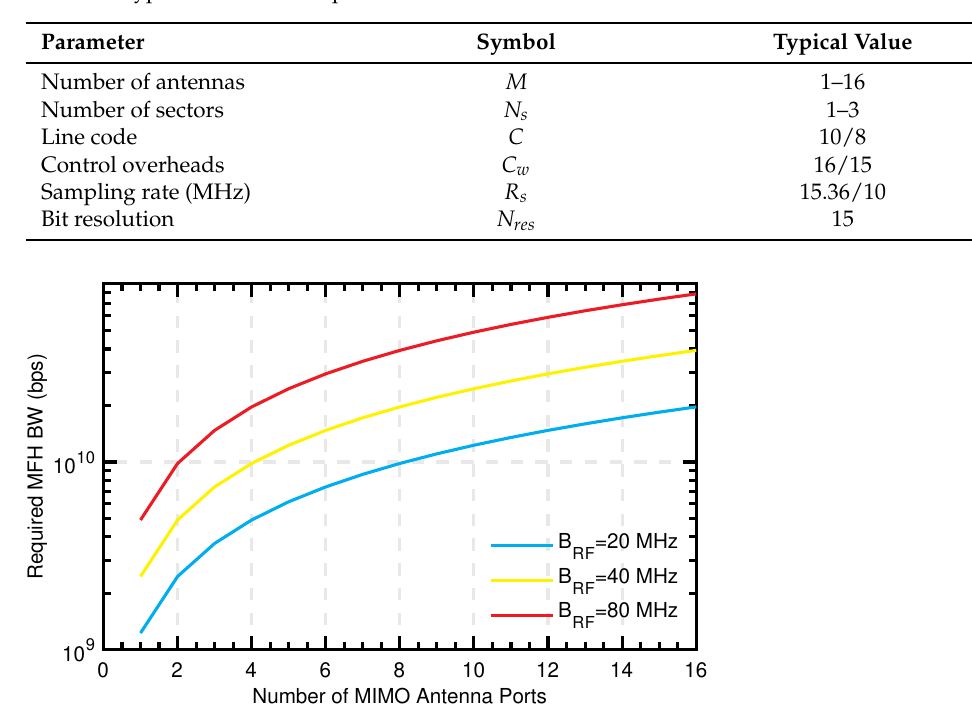
Table 13. Typical transmission parameters.